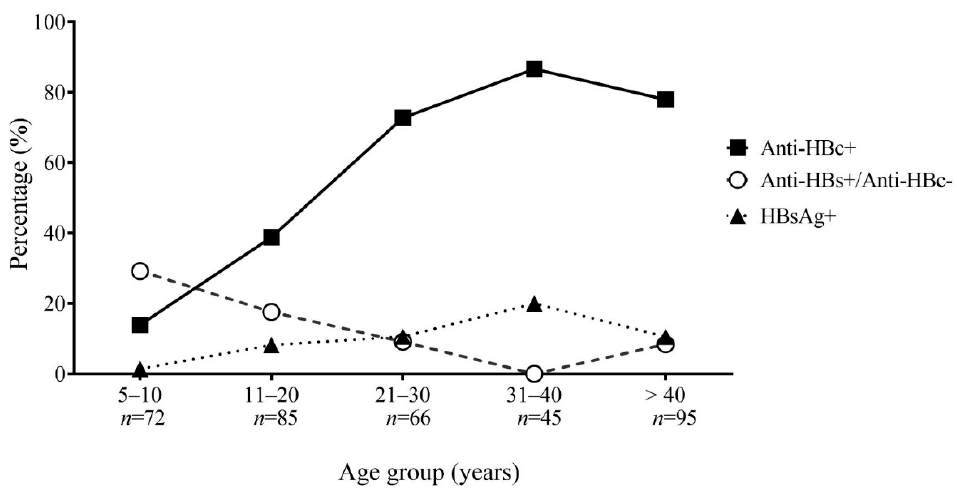
Figure 1. Age-stratified Hepatitis B serology.